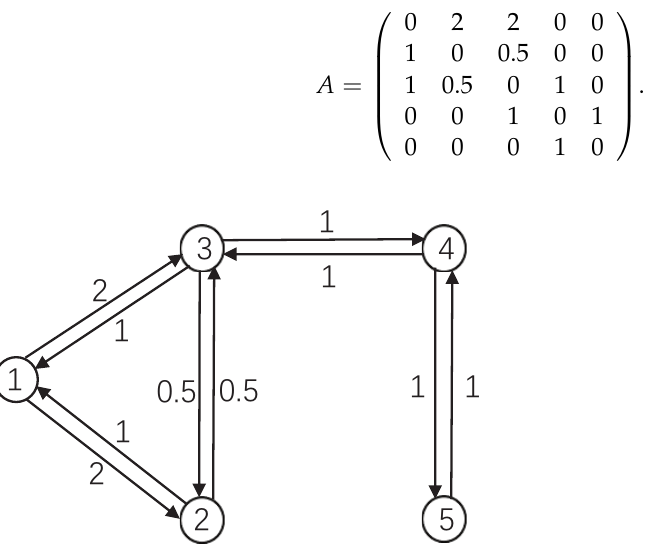
Figure 7. Communication topology of leaderless multi-agent based supply chain